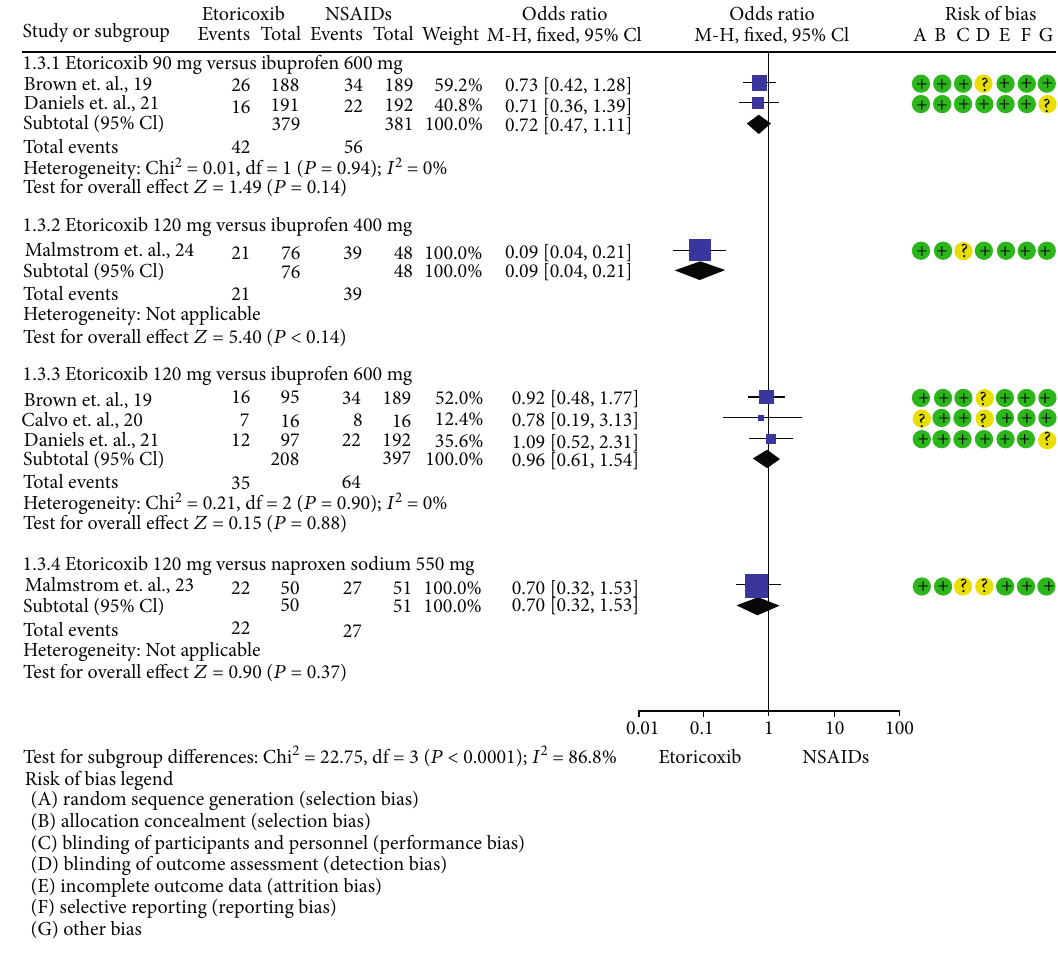
Figure 4: Pooled evaluation according to the etoricoxib dose and the number of patients needing rescue analgesic